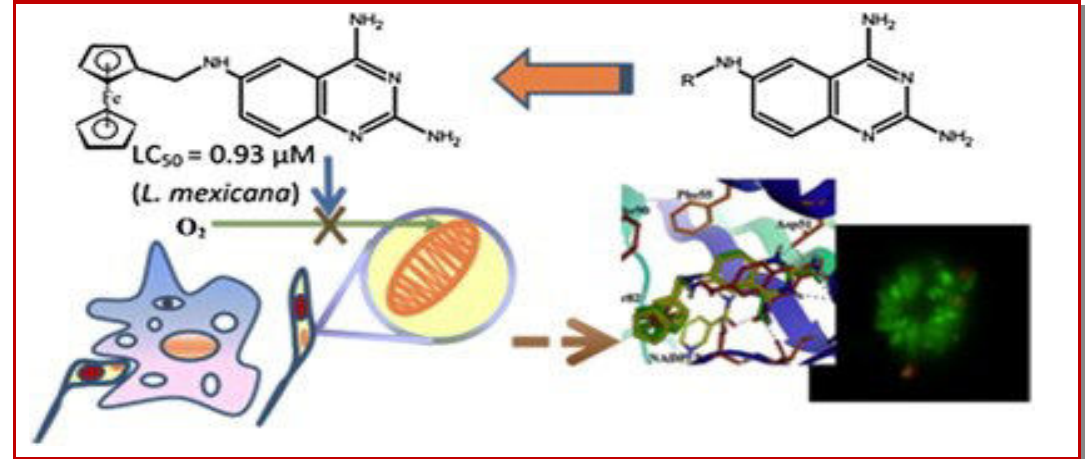
Figure 5: Molecular docking study N 6 -(ferrocenmethyl)quinazolin-2,4,6-triamine as anti-leishmanial